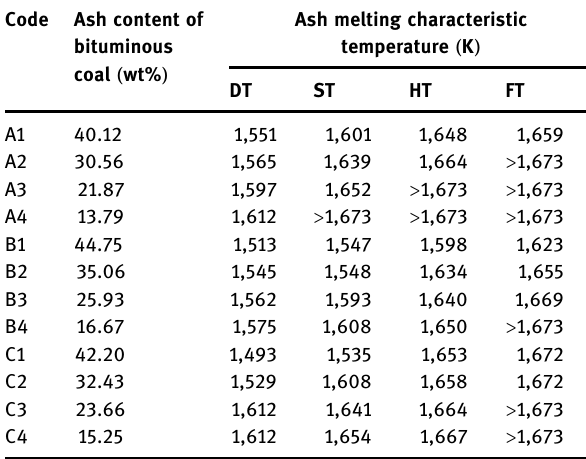
Table 5: Experimental results of ash melting characteristics of dif - ferent blended coal schemes